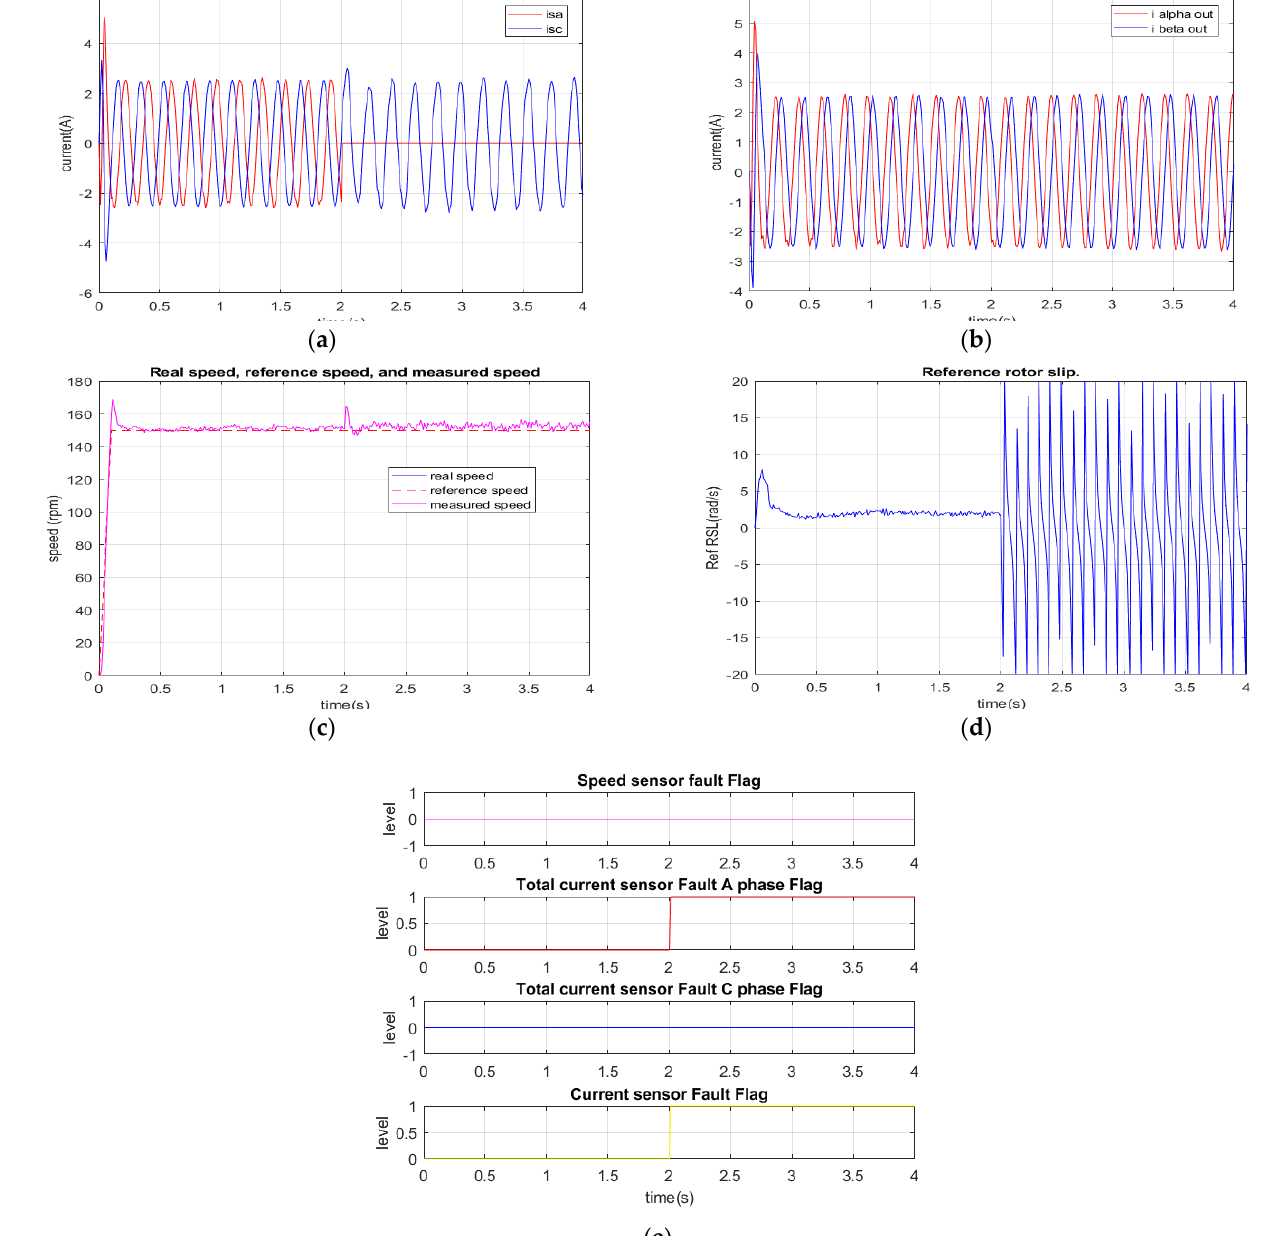
Figure 13. Experimental results: total A phase current sensor failure at 2s. ( a ) Measured currents; ( b ) stator current vector components for FOC controllers (FTC outputs); ( c ) reference, real, measured speeds; ( d ) reference rotor slip; ( e ) sensor fault indications.